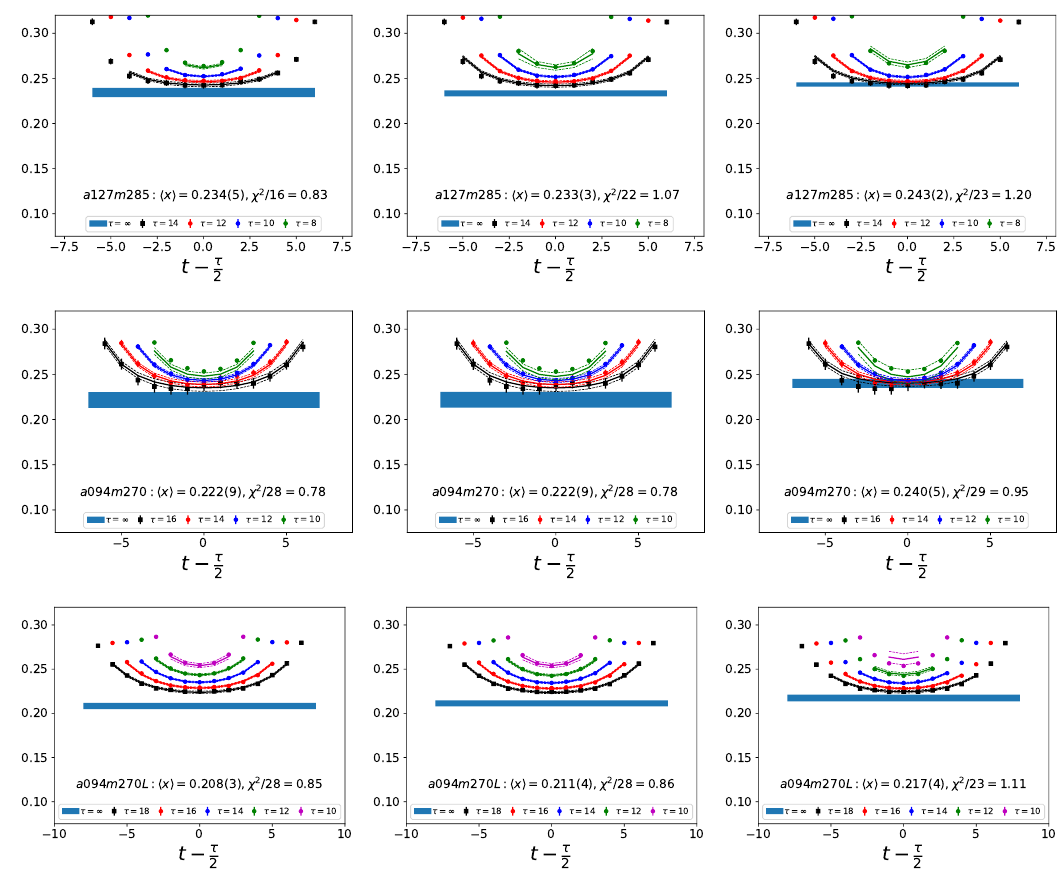
Figure 7 . Data and fits to remove excited-state contamination in the extraction of the helicity moment h x i for a 127 m 285 (top row), a 094 m 270 (middle row), and a 094 m 270 L (bottom row) ∆ u − ∆ d ensembles. The data for the ratio C 3 pt ( τ ; t ) /C 2 pt ( τ ) is scaled using eq. (3.9) to give h x i O the fit parameters are listed in table 8. The rest is the same as in figure